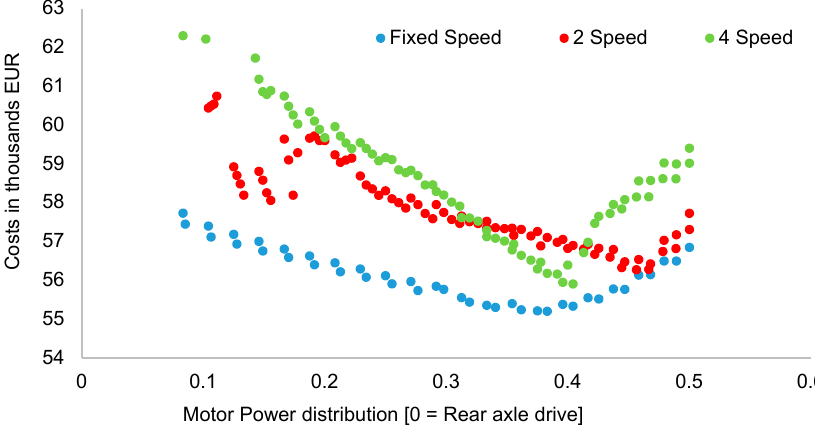
Figure 13. Cost dependency of motor power distribution.